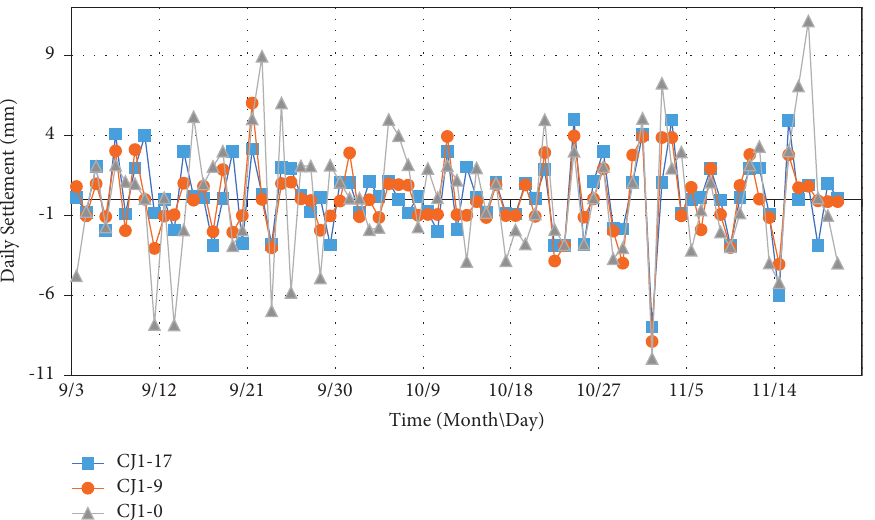
Figure 12: Daily settlement of CJ1-17, CJ1-9, and